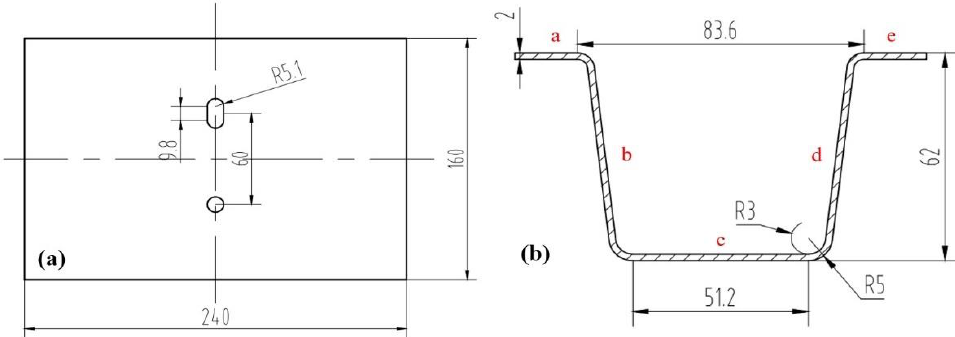
Figure 8. Dimensions (mm) of ( a ) blanking sheet and ( b ) U-shaped part.